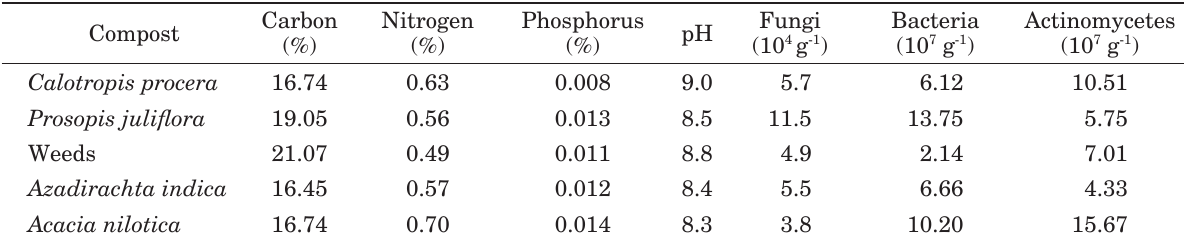
Table 1. Compost